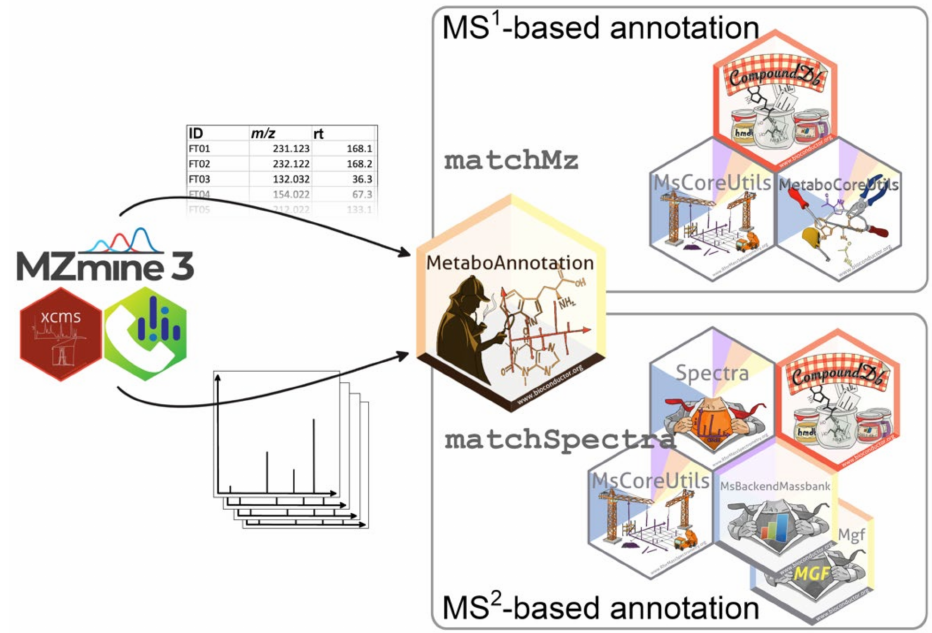
Figure 1. R-package ecosystem for MS 1 - and MS 2 -based annotations. Functionality from the